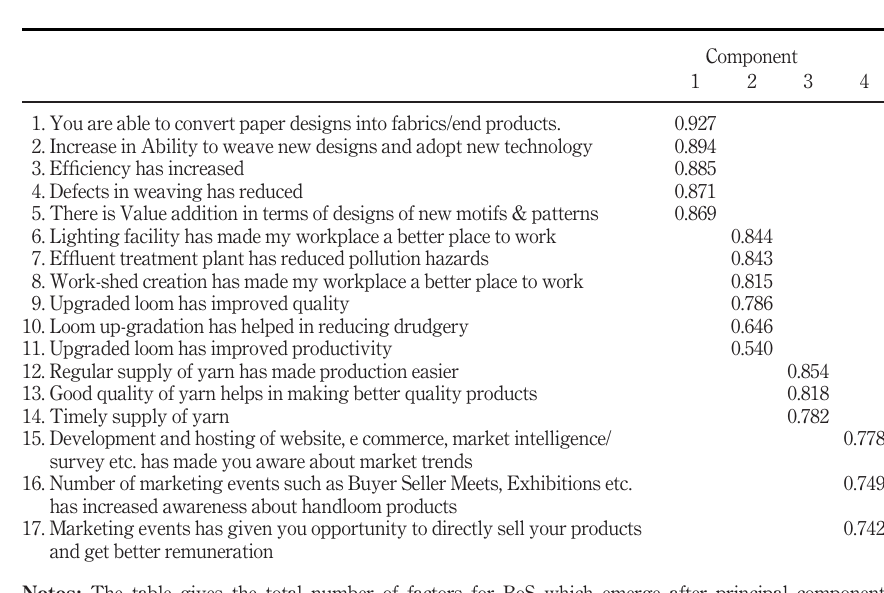
Table 5. Result of rotated component matrix for BoS